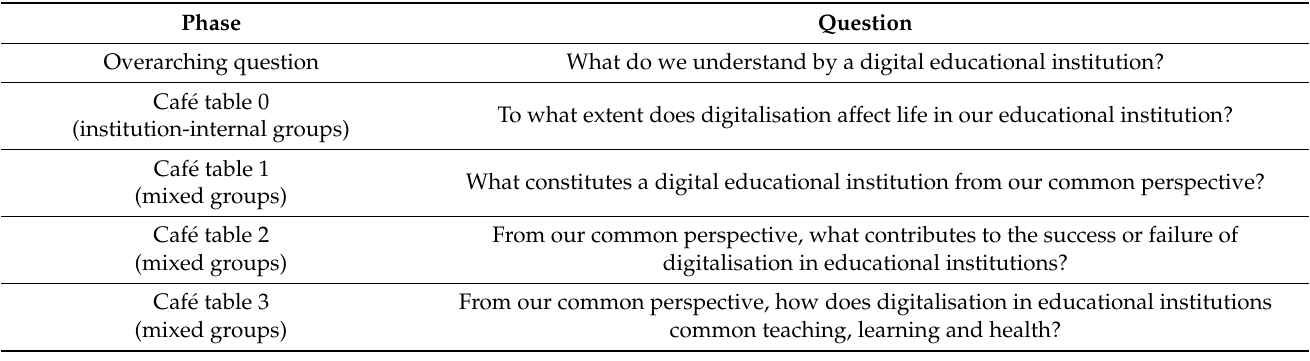
Table 2. Examples of questions in the online World Caf é “educational institution”.